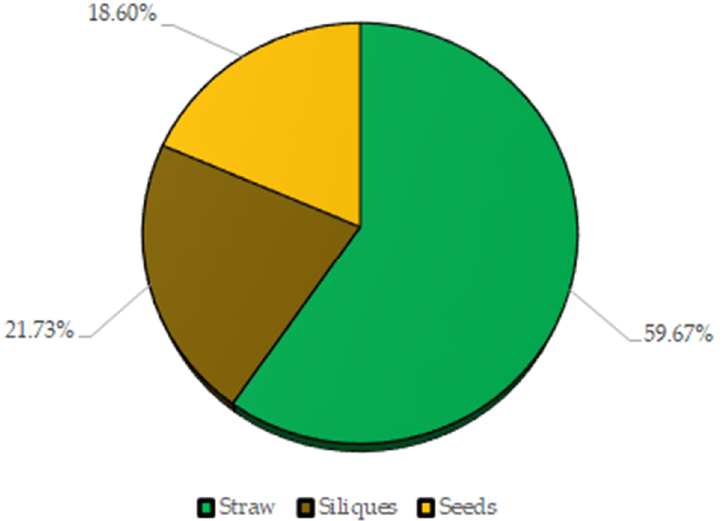
Figure 3. Percentage of straw, siliques and seeds of the aboveground biomass.